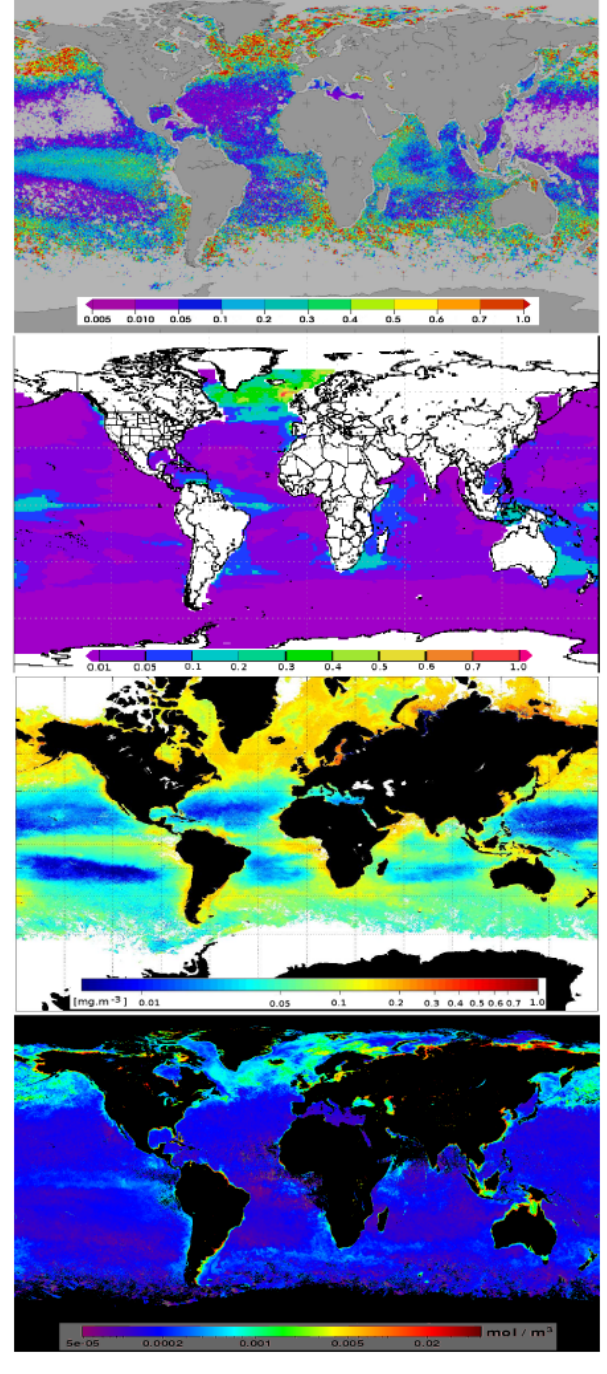
Fig. 8. Comparison of the PhytoDOAS coccolithophore chl a [mgm − 3 ] (upper panel) with the NOBM coccolithophore chl a [mgm − 3 ] (second upper panel), the haptophytes chl a [mgm − 3 ] (third panel) and the MODIS PIC concentration [molCaCO 3 m − 3 ] (lower panel). All results represent the seasonal-mean values over the over the months of July, August and September